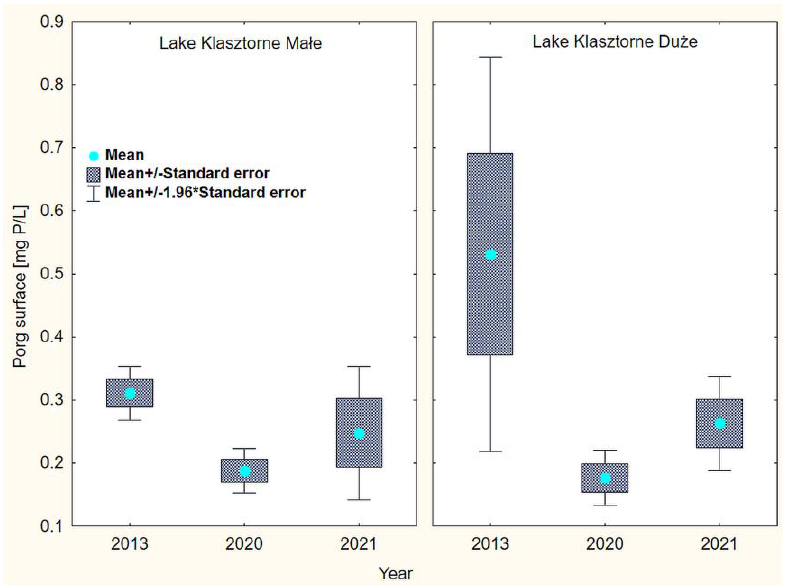
Figure 9. Average annual values of organic phosphorus (P org .) in the surface water of Klasztorne lakes in selected research years. lakes in selected research years.